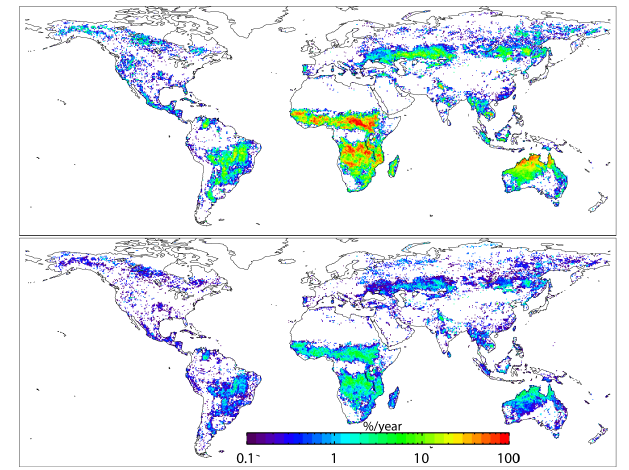
Figure 13. The 1997–2008 mean annual burned area (% of grid cell) from four satellite data sets (top) and associated one-sigma uncertainties (bottom). Reproduced with permission from Giglio et al.